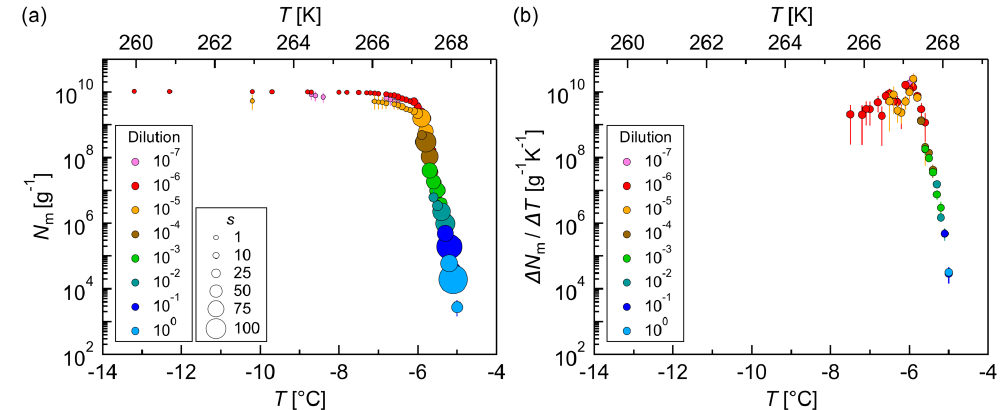
Figure 8. Measurements of dilution series of fungal IN ( Mortierella alpina 13A). (a) Cumulative number of IN ( N m ) and (b) differential number of IN ( (cid:49)N m /(cid:49)T ) per unit mass of mycelium vs. temperature ( T ). Droplets of the same dilution of three independent measurements were added to a total droplet number of 288 (3 × 96 droplets). Symbol colors indicate different dilutions; symbol size indicates the number of frozen droplets per 0.1K bin ( s ). The error bars were calculated using the counting error and the Gaussian error propagation. The temperature error is 0.2K.